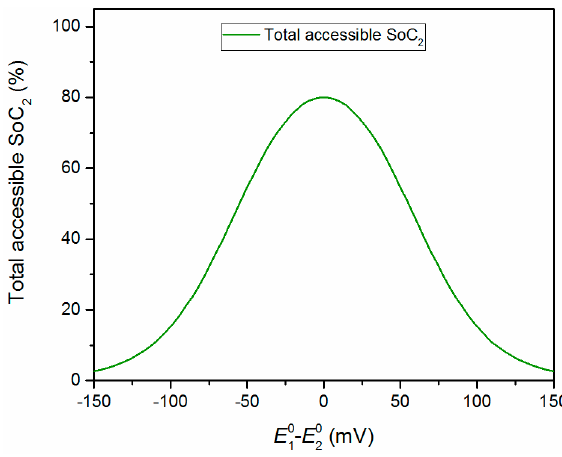
Figure 5. SoC 2 as a function of potential mismatch between 𝐸 (cid:2869) (cid:2868) and 𝐸 (cid:2870) (cid:2868) . One way to circumvent the limited accessed solid booster capacity from mismatching potentials is to use two different dissolved redox-active species with respective potentials higher and lower than that of the solid booster [8–10]. This strategy was illustrated in many initial systems, where for example solid FePO 4 was charged with the dibromoferrocene (FcBr 2 /FcBr 2+ ) redox couple and discharged with the ferrocene (Fc/Fc + ) redox couple. In this case, the same reaction scheme, i.e., (v)–(vii), will take place during charging. However, to form red 3 ,